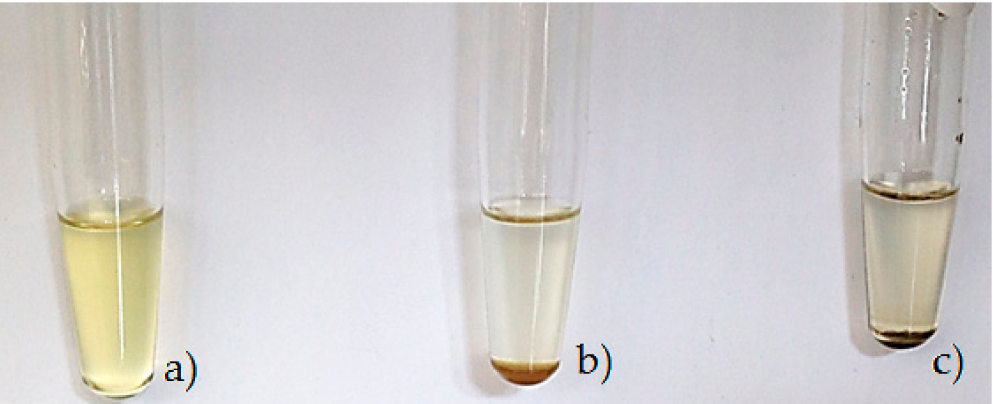
Figure 5. The catalytic reaction mixture of ( a ) Pt(PLLA-Bipy)Cl 2 under reaction conditions, ( b ) Pt(PLLA-Bipy)Cl 2 before and after catalysis at room temperature, ( c ) Pt(Bipy)Cl 2 at room and reaction temperature.